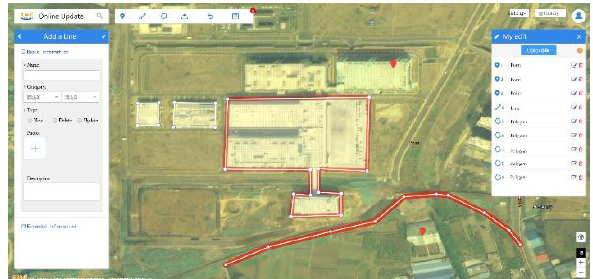
Figure 5. The interaction of online